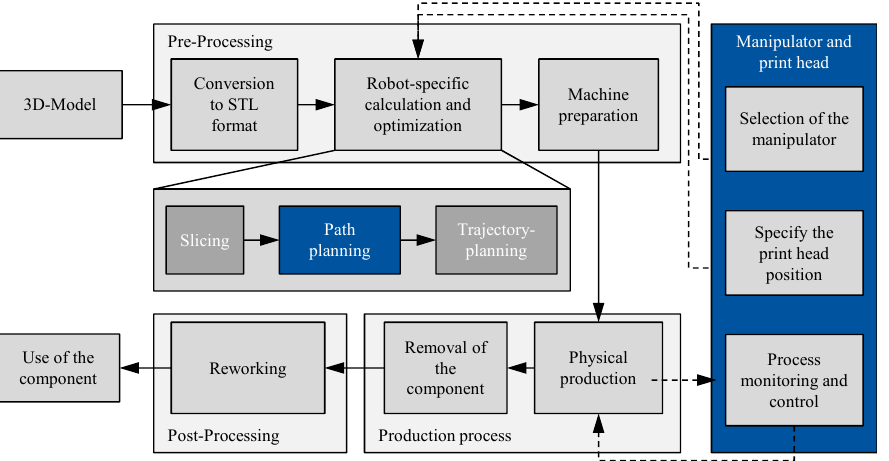
Figure 3. Process chain of